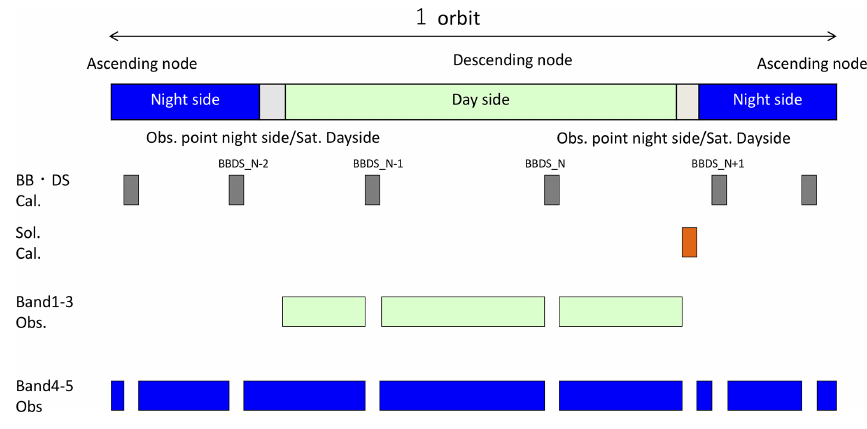
Figure 3. Typical calibration operations during an